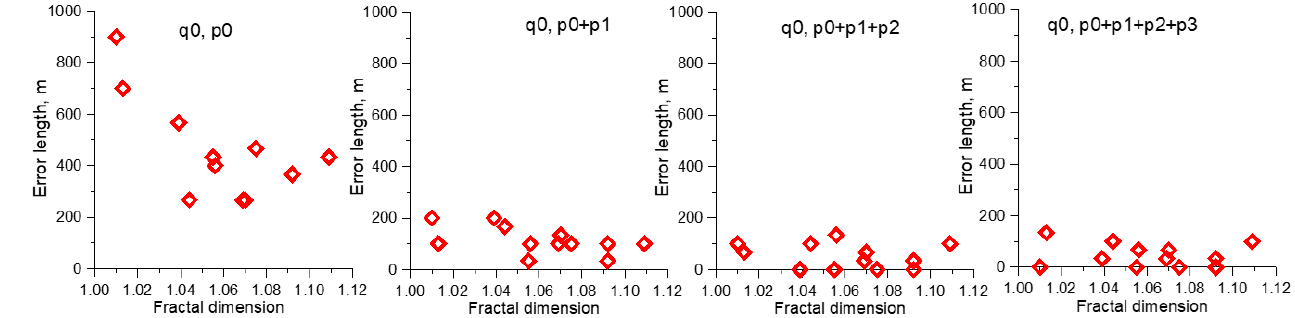
Figure 12. The average length of the error relative to the number of loops and the number of monitoring sensors applied.